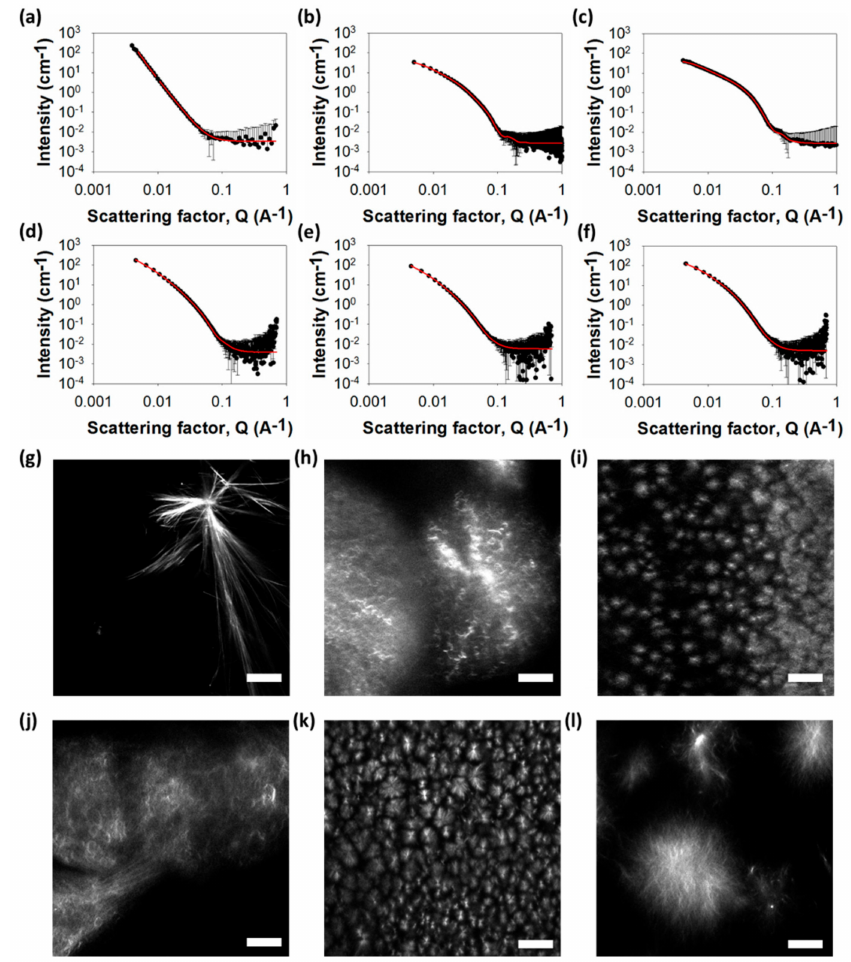
Figure 3. Small angle neutron scattering (SANS) and microscopy of gels. (Top) SANS scattering for ( a )–( f ) gel 1 – 6 . In all cases, the black circles represent the SANS data and the red lines show the fit to the data. (Bottom) Representative confocal microscopy images for gels formed from ( g ) 1 ; ( h ) 2 ; ( i ) 3 ; ( j ) 4 ; ( k ) 5 ; ( l ) 6 . All gels at 5 mg mL − 1 and the scale bar represents 20 µ m in all